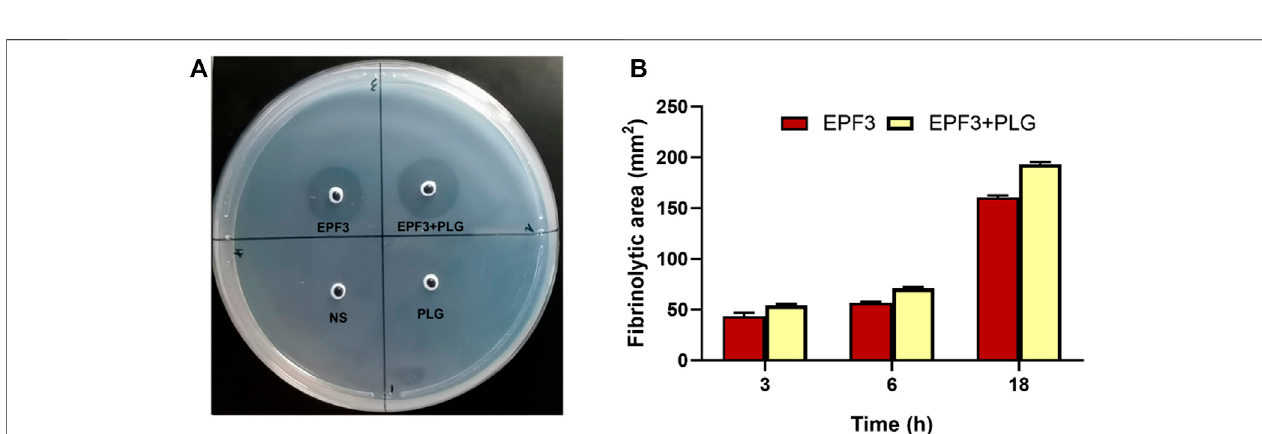
FIGURE 10 | Analysis of fi brinolysis and plasminogen activation by EPF3. (A) : fi brin plate. 10 µL sample solutions (Saline, plasminogen, EPF3, a mixture of EPF3, and plasminogen) were placed on the fi brin plates and then incubated at 37 ° C for 18 h (B) : The fi brinolytic area at 3, 6, and 18 h ( n (cid:1) 3).